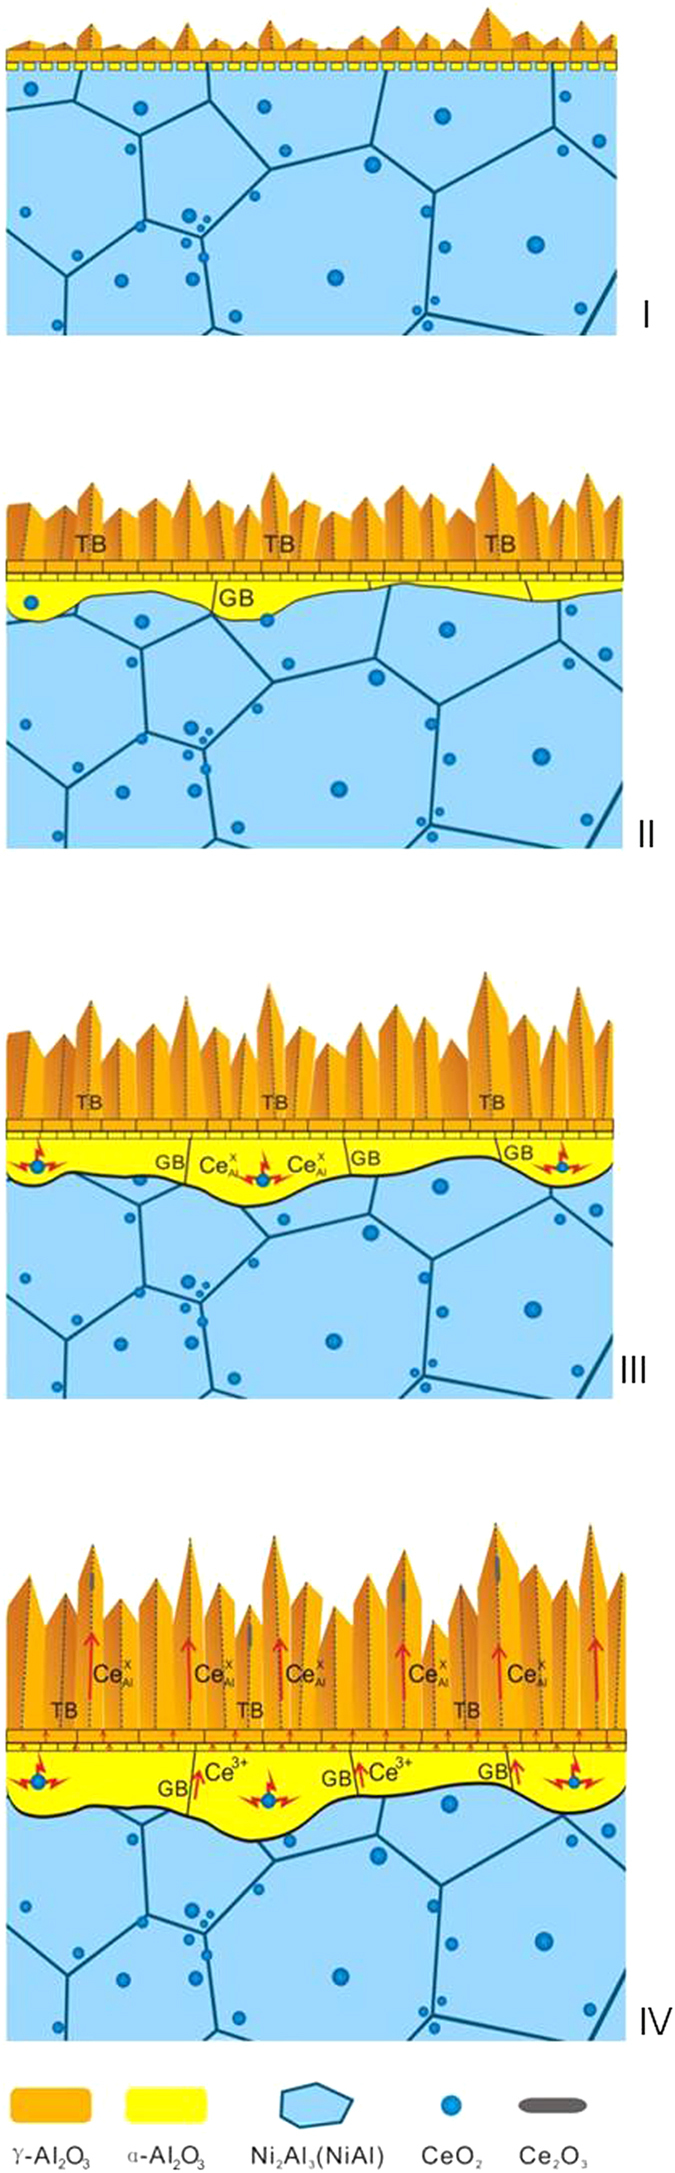
Schematic steps for the evolution of the CeO2 dispersion in the aluminide from being incorporated into inner Al2O3 scale to being precipitated as Ce2O3 in the outer Al2O3 scale.